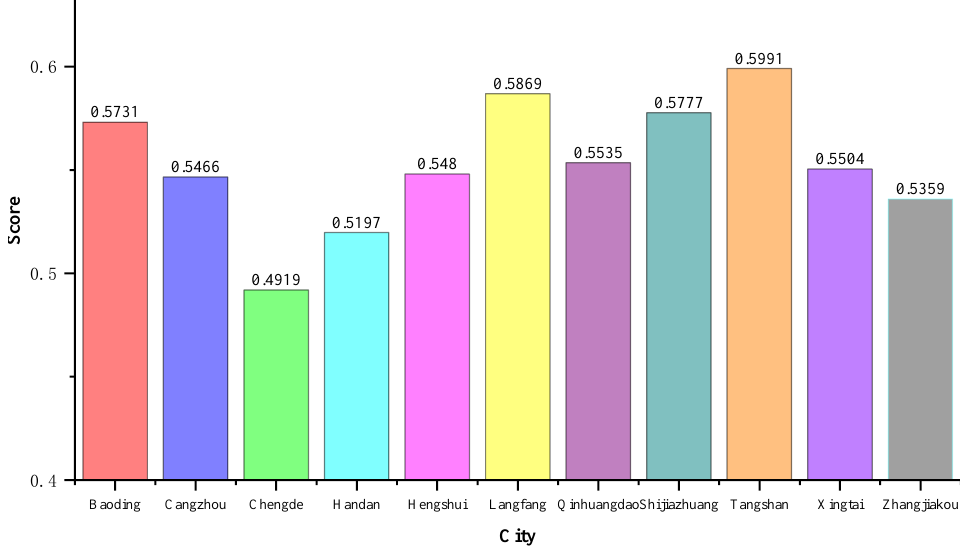
Figure 7. Coordination prediction results for